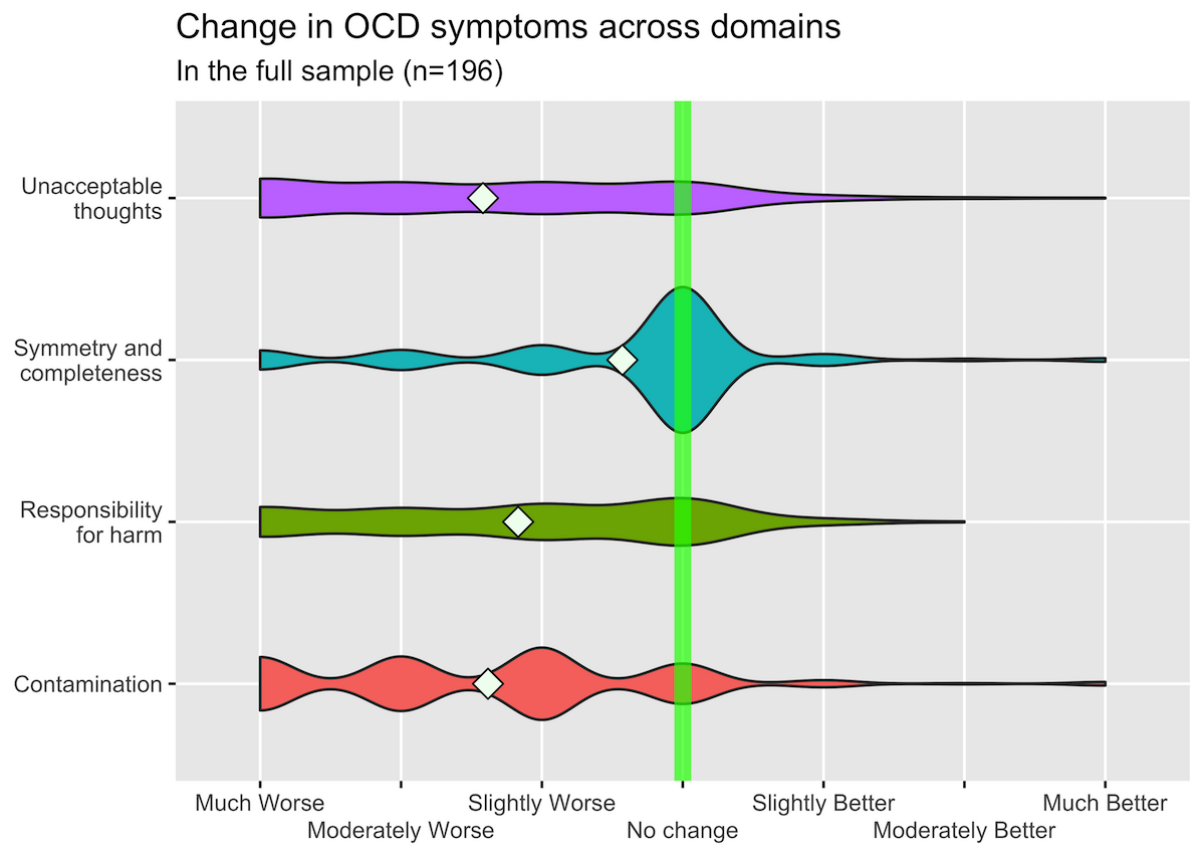
Figure 1. Changes in obsessive-compulsive disorder symptom severity across dimensions, as defined by the Dimensional Obsessive-Compulsive Scale. White diamonds correspond to sample means. Participants indicated the extents to which their symptoms across the four dimensions of obsessive-compulsive disorder (“unacceptable thoughts,” “symmetry and completeness,” “responsibility for harm,” and “contamination”) had changed since the onset of the COVID-19 pandemic, with scores ranging from −3 (much worse) to 3 (much